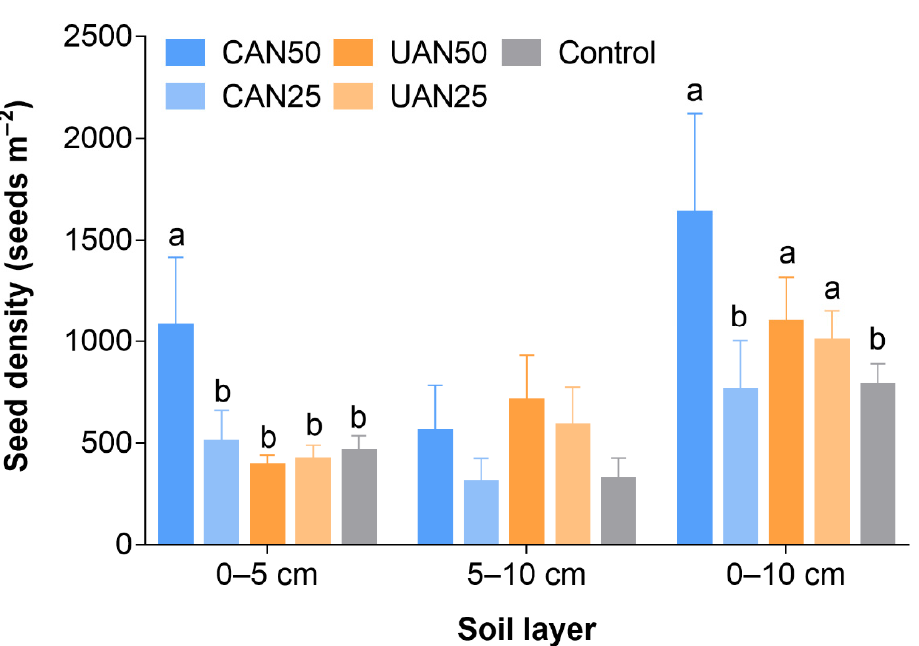
Figure 1. Seed density (number of seeds m − 2 ) of the soil seed bank as affected by soil layer and five N-addition treatments. Values are means + standard error of mean (SEM). Within each soil layer, means with different letters are significantly different. N-addition treatments are described in Table 1 and in the text. Table 1. Number (No.) of emerged seedlings per plots and the important value index (IVI) of the detected species in the soil seed bank (0–10 cm) as affected by five N addition treatments.